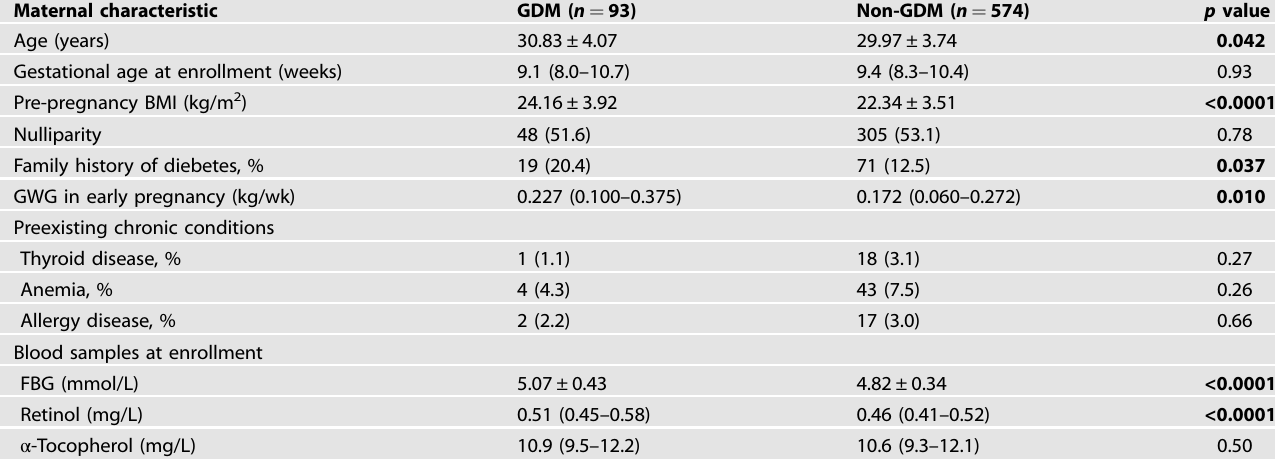
Table 1. Basic characteristics of women with GDM and non-GDM ( N = 667).